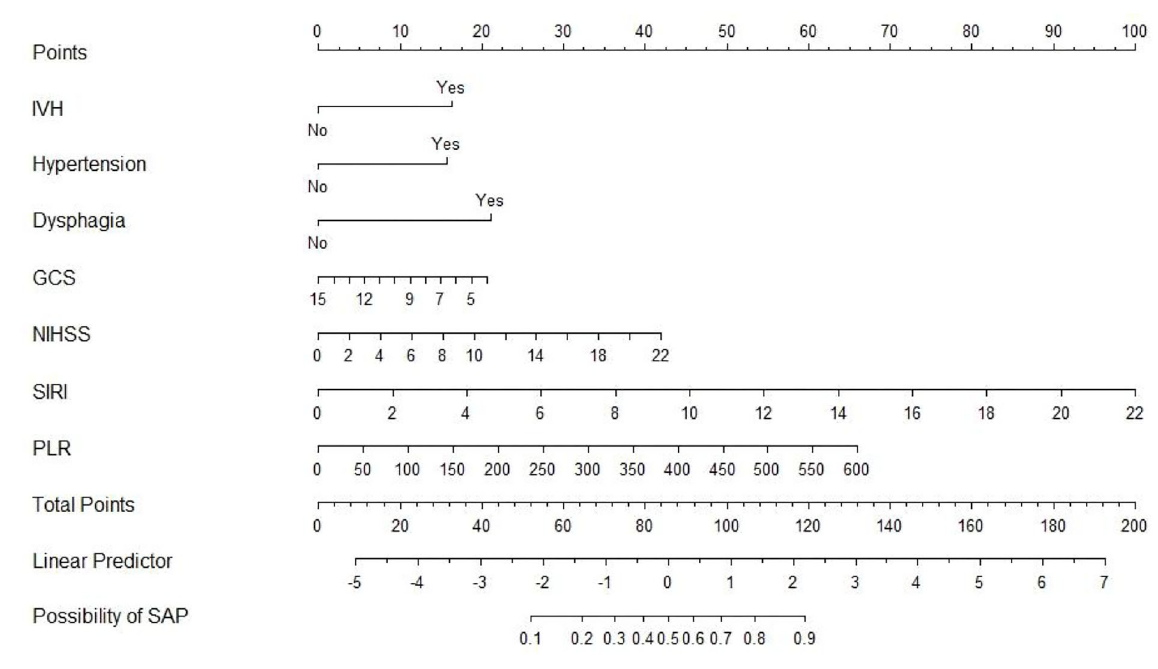
FIGURE2 Nomogram for predicting SAP after SICH.